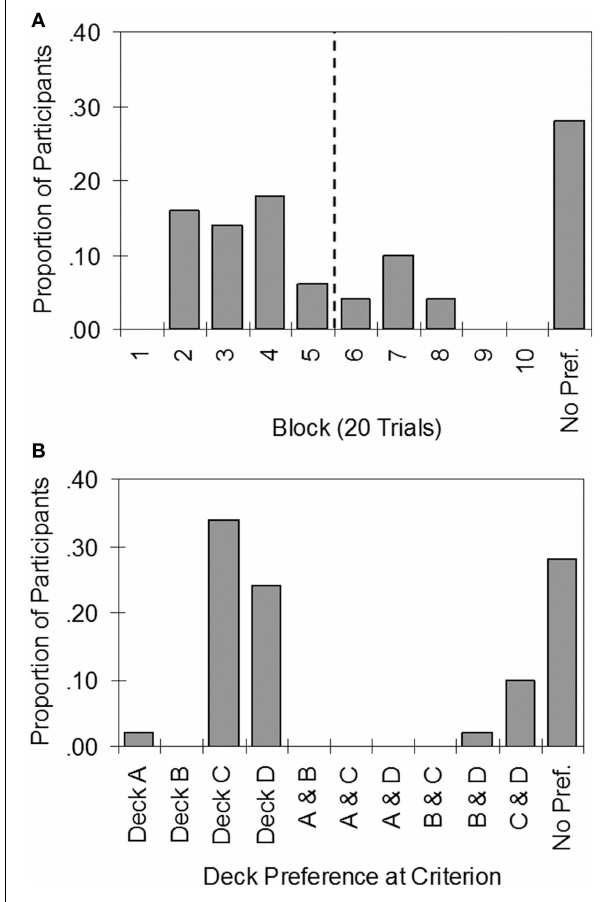
FIGURE 4 | Histograms summarizing the results of applying the stability criterion to individual data in the Iowa Gambling Task. (A) Proportion of participants to reach the stability criterion by each block of trials (vertical dashed line demarcates trials 1–100 and 101–200). (B) Proportion of participants who preferred each deck or pair of decks. No Pref., No preference by the end of the